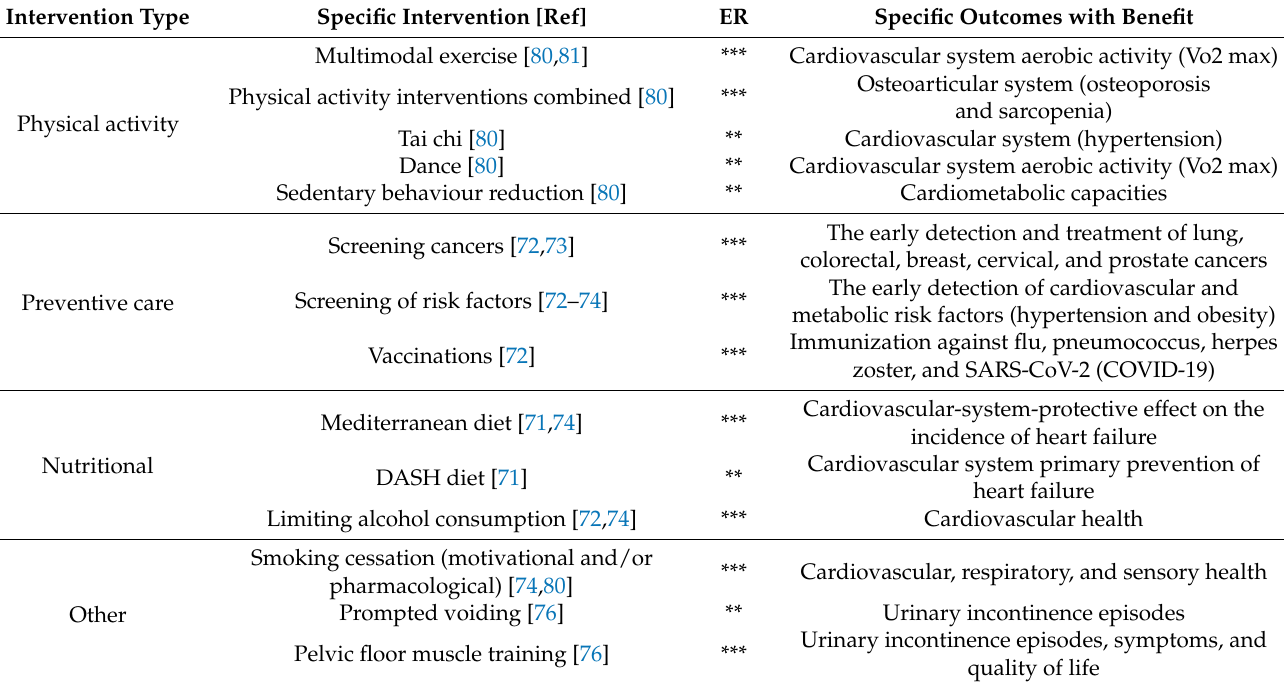
Table 8. Identified interventions for physiological